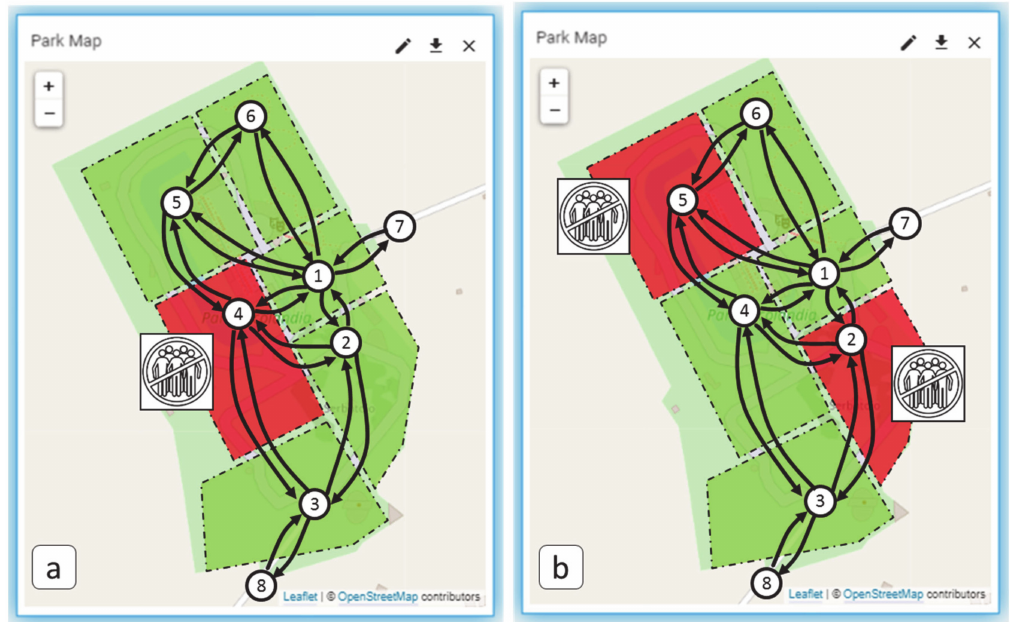
Figure 6. Two examples of a crowd management plan in case of an overcrowding alarm active at ( a ) node 4, and ( b ) nodes 2 and 5.